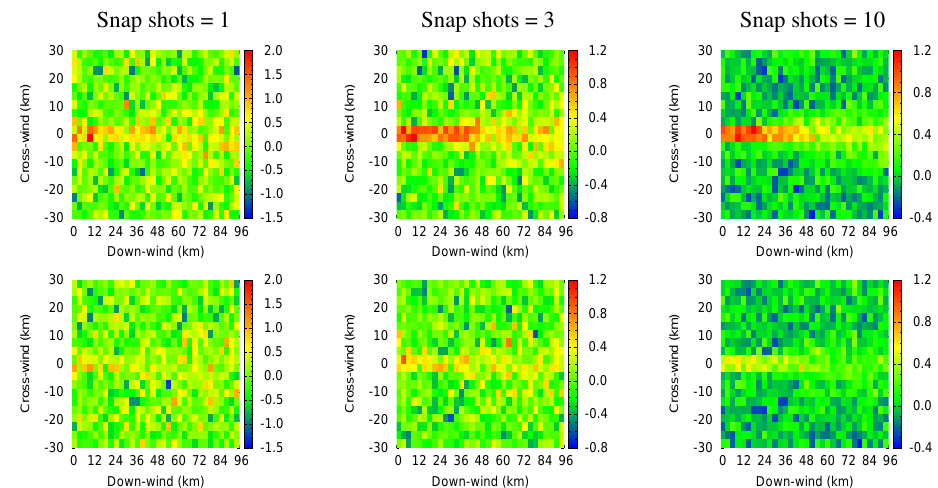
Fig. 20. The upper and lower rows show the retrieved enhancement (in ppm) of X CO above the background estimated from one, three and ten snapshots when the wind is from the west with speeds of 5ms − 1 and 10ms − 1 . The plume from the power plant is assumed to be clean (devoid of aerosol). The x- and y-axes are distances in km. The power plant is located at (0 , 0) . Note the different colour bar ranges.